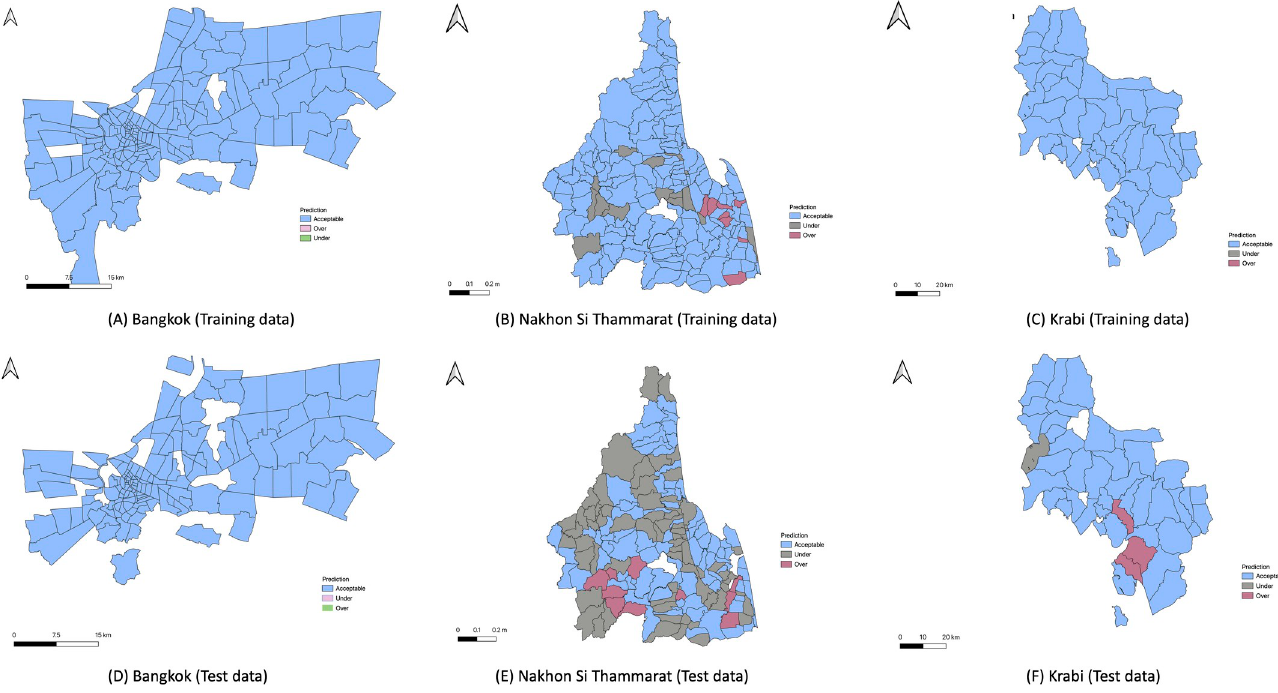
Fig 6. The risk maps of Bangkok, Nakhon Si Thammarat, Krabi for the training (2015–2017), and test (2018) data. White color represents sub-districts with no data. The choropleth map in this figure was produced using ArcGIS version 10.4 (Esri, Redlands, CA, USA). Source of shapefile: United Nations Office for the Coordination of Humanitarian Affairs https://data.humdata.org/dataset/thailand-administrative-boundaries.